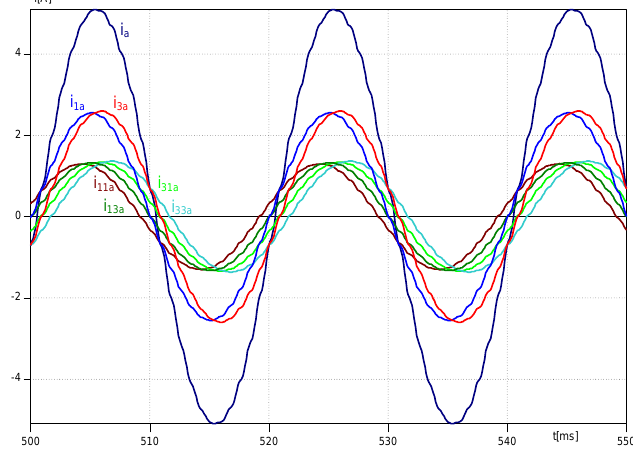
Figure 20. Line current waveforms: i 1 a , i 3 a of 3CR λ 2; i 11 a , i 13 a of 3CR λ 1; and i 31 a , i 33 a of 3CR λ 3 in relation to the line voltage.